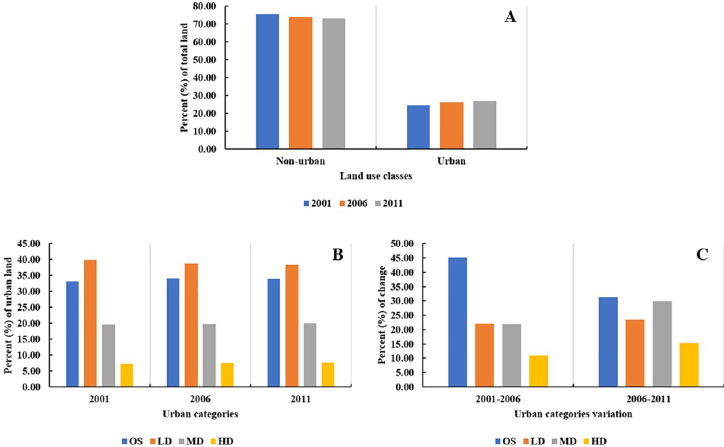
Fig 3. Urbanization dynamics between 2001 and 2011. (A) Non-urban and urban variation (percent of total land) in 2001, 2006 and 2011.(B) Urban categories variation (percent of urban land) in 2001, 2006 and 2011.(C) Urban categories variation (percent of change) between 2001 and 2011.